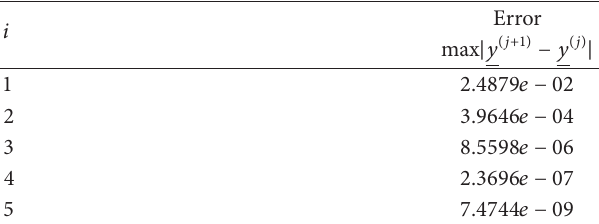
Table1:Tableshowingtheabsoluteerroraftereachiterationof (28), where 𝑛 = 100